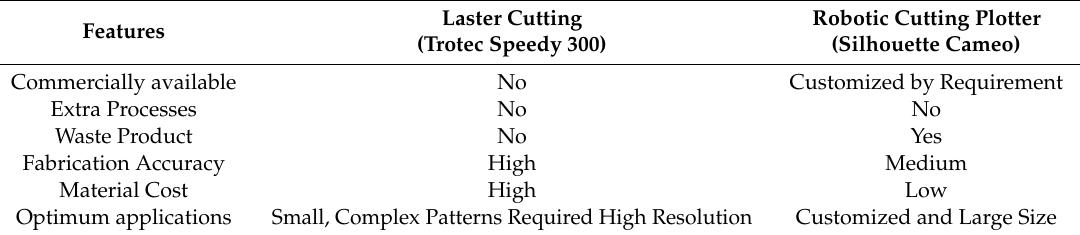
Table 8. Comparison of direct cutting